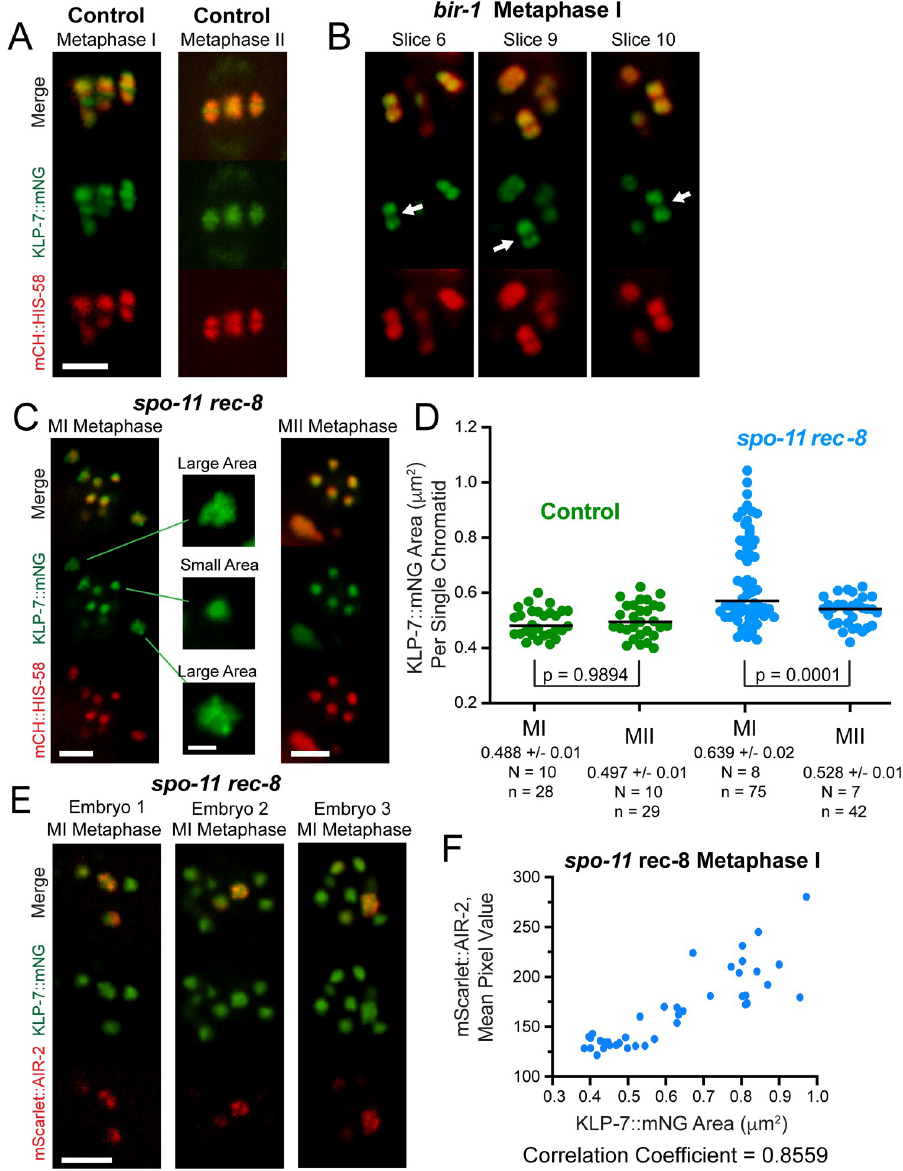
Fig 8. Survivin-dependent AIR-2 is required for KLP-7 recruitment to the midbivalent ring. (A) KLP-7::mNG localized to the two lobes and the ring complex (indicated by an arrowhead) of bivalents in 7/7 living control metaphase I embryos, but localized only to the two lobes in (B) 8/8 bir-1(fq55) [E69A D70A]) embryos . (Arrows indicate bivalents which clearly lack a ring complex). Bar = 3 μ m. (C) In living spo-11 rec-8 MI metaphase spindles, one subset of chromosomes had a small area of KLP-7::mNG and a second subset had a larger area of KLP-7::mNG that was unevenly dispersed around the DNA. Bar, spindle images = 3 μ m. Bar, single chromosome images = 1 μ m. (D) KLP-7::mNG areas were determined in spo-11 rec-8 MI metaphase and MII metaphase spindles. N, number of embryos. n, number of chromosomes. (E) Single plane Airyscan images from z-stacks of 14/14 fixed spo-11 rec-8 embryos showed expanded KLP-7::mNG on chromosomes with the highest mScarlet::AIR-2 fluorescence intensity. Bar = 3 μ m. (F) Graph of mScarlet::AIR-2 mean pixel value relative to KLP-7::mNG area from live images. The Pearson r correlation coefficient is 0.8559. N = 8, n = 40, p <